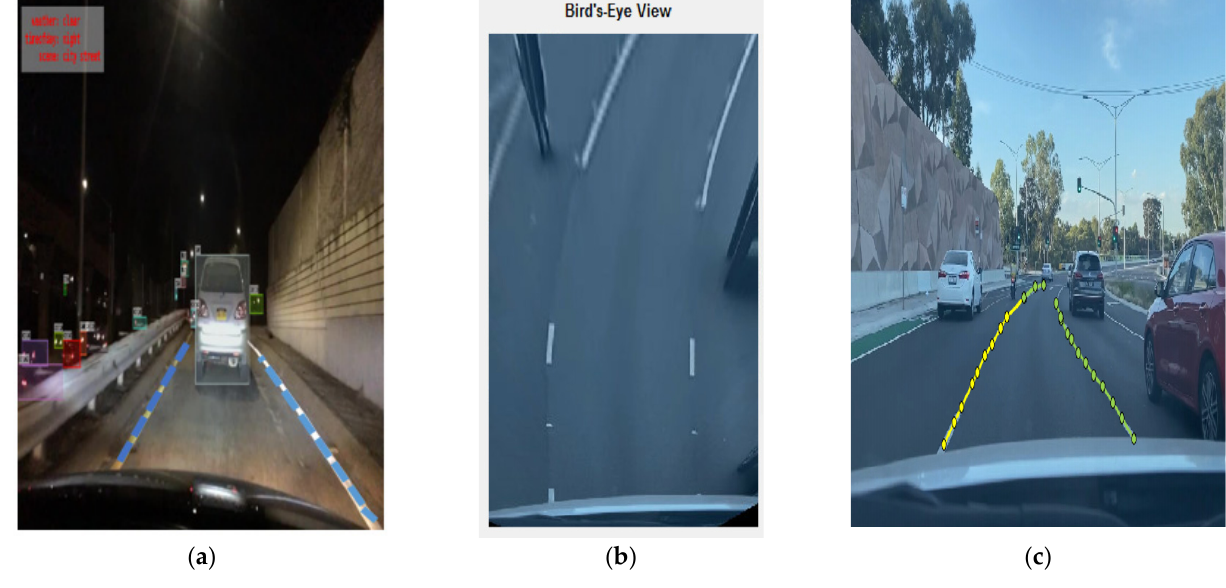
Figure 13. Lane detection using BDD100K secondary dataset ( a ), bird’s eye view for close view of lane ( b ), and primary dataset ( c ). Table 4. Performance evaluation of the algorithm.